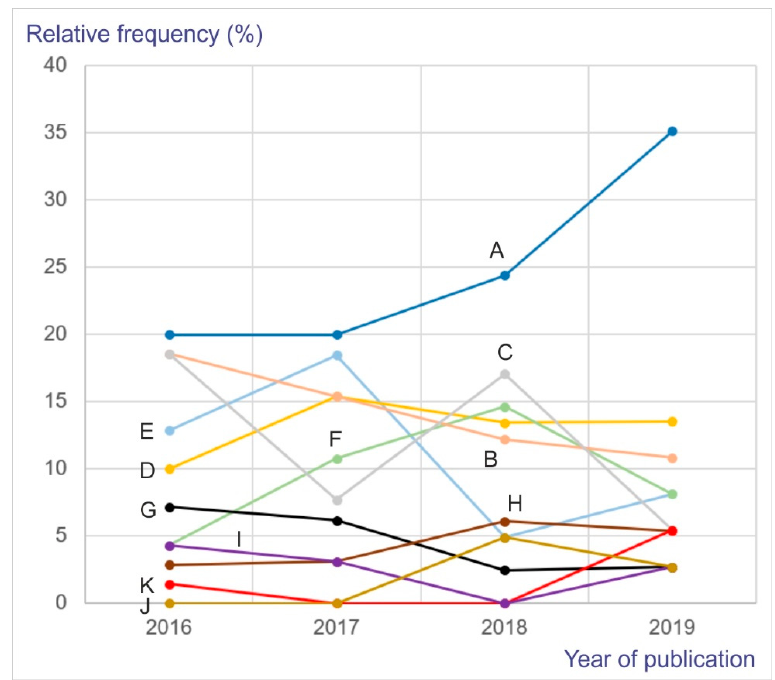
Figure 3. Relative frequency of PS ‐ OSs characteristics described in papers of our paper database for individual years of the observed time period—results of the first assignment process (paper groups are marked with the same letters as the paper groups listed above, see Table 1.; the color of graphs of individual PS OSs characteristics is the same as the color of the column of the PS OSs characteristic in Figure 1.). Energies 2020 , 13 , x FOR PEER REVIEW